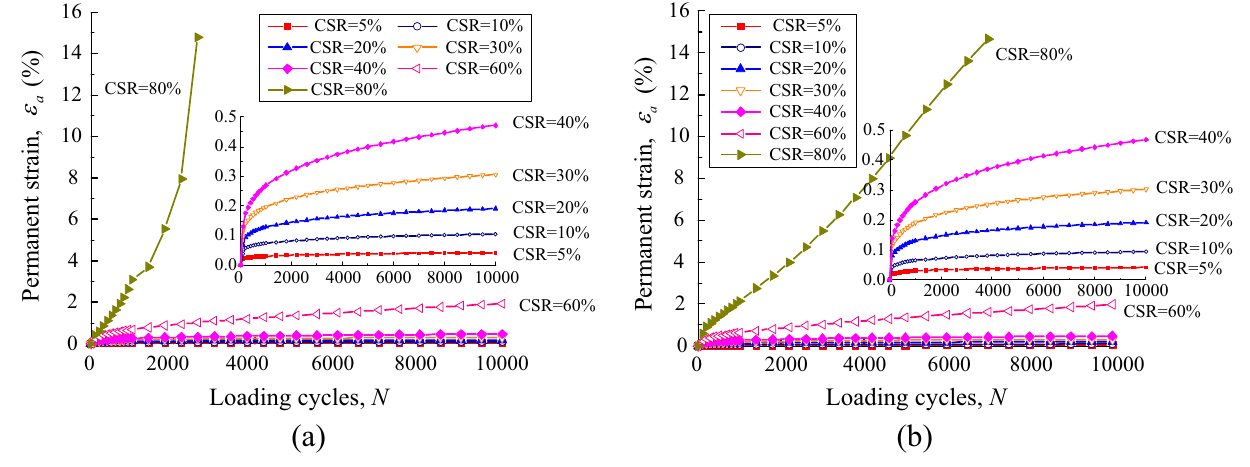
Figure 6. Permanent deformation plotted against loading cycles for UGM samples with DoC = 0.95 at the confining pressure of ( a ) 40 kPa and ( b ) 60 kPa.